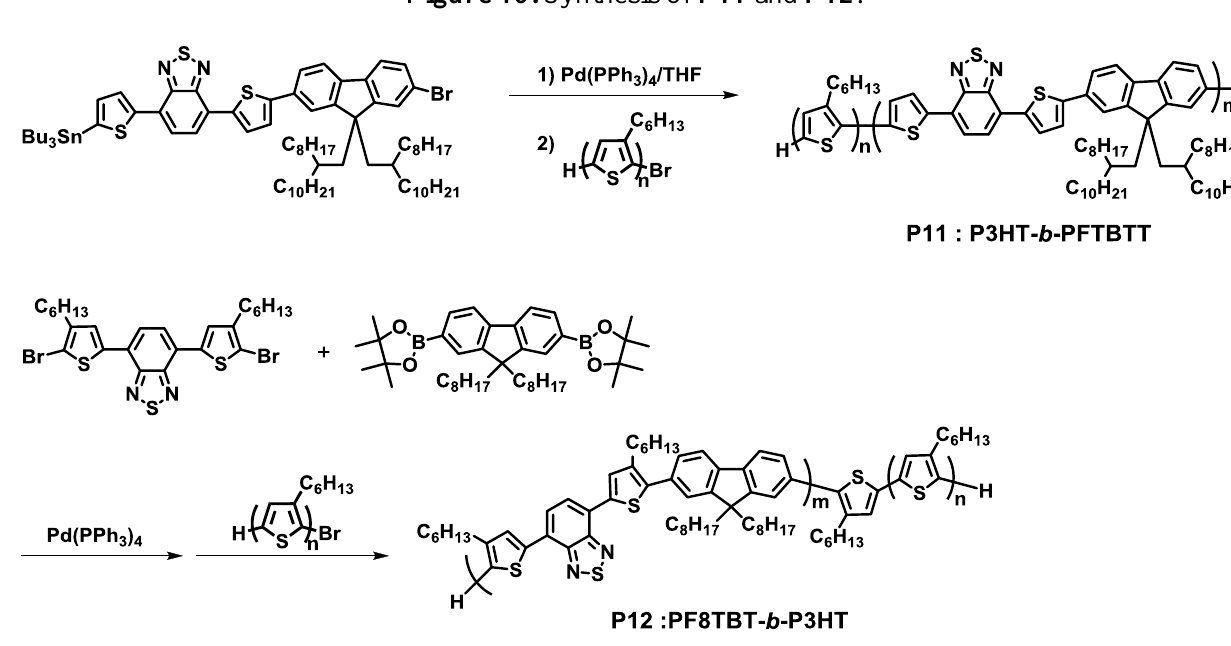
Figure 10. Synthesis of P11 and P12